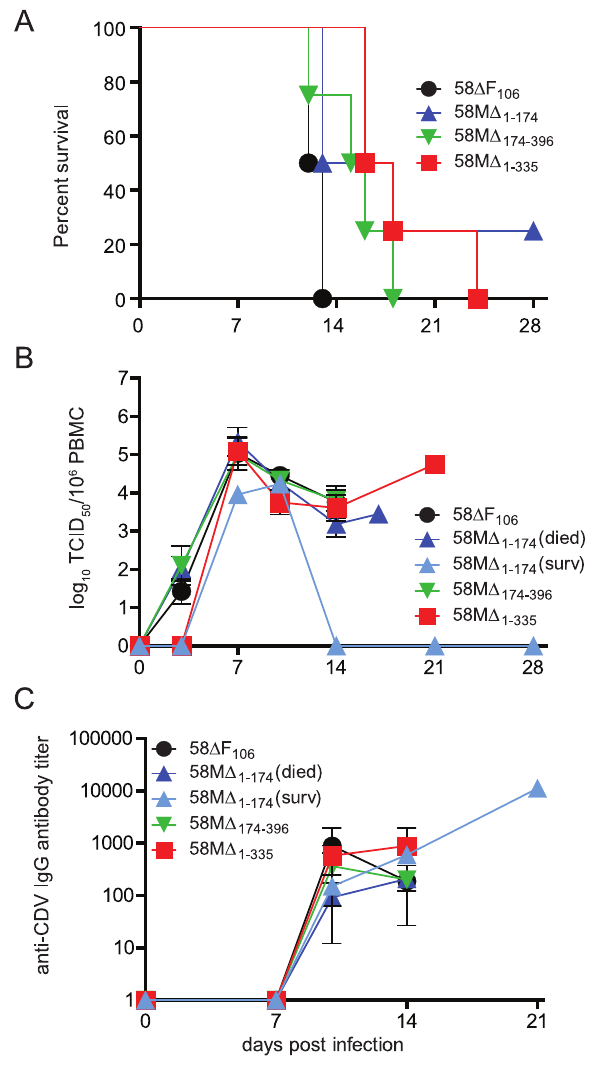
Figure 6. Characterization of M 3 9 UTR mutants in ferrets. ( A ) Survival curve of ferrets infected with the different mutants. Animals were infected with 10 5 TCID 50 intranasally. Death of an infected animal is indicated by a step down on the graph. ( B ) Course of cell-associated viremia displayed as the number of CDV-infected cells per million peripheral blood mononuclear cells (PBMC). ( C ) CDV-specific IgG response in serum samples over the course of the disease. An immunoperoxidase monolayer assay was performed and antibody titers are displayed as reciprocals of the highest antibody dilution at which viral antigen was observed. Error bars indicate the standard deviation.